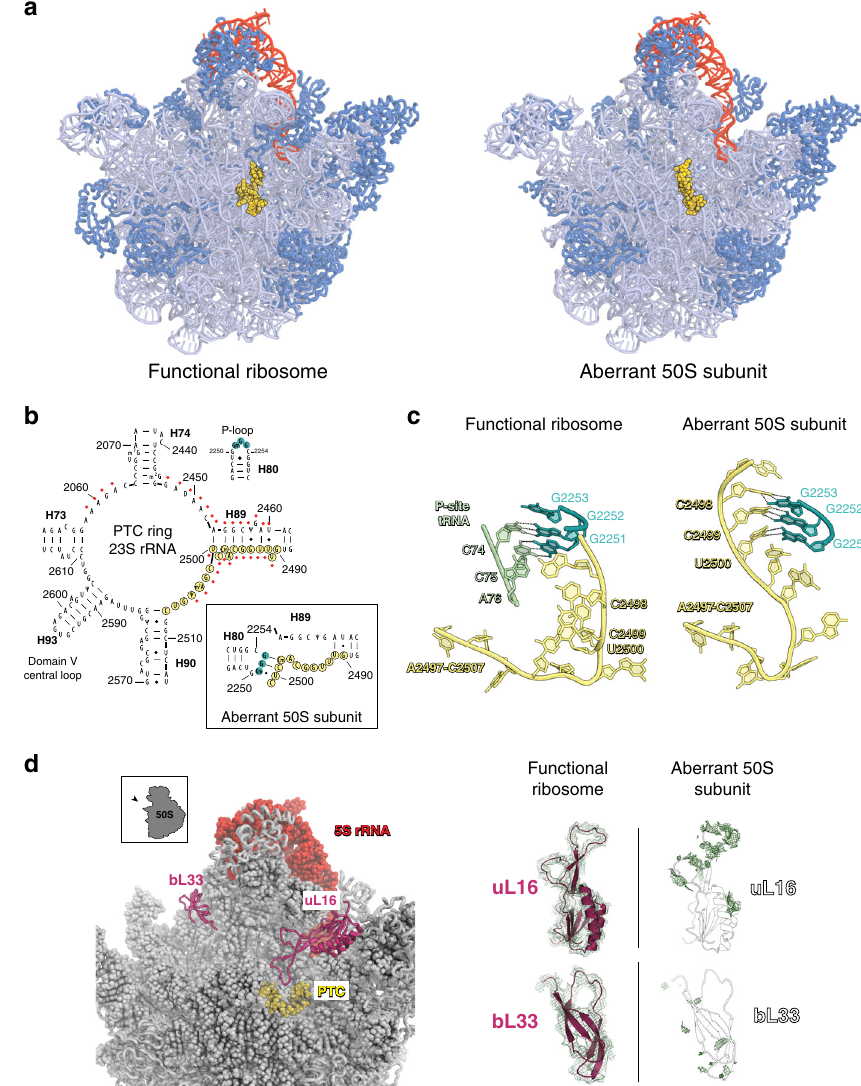
Fig. 7 The structure of the aberrant 50S subunits with 23S-cp5S rRNA. a Cryo-EM reconstruction of the structure of the 50S subunit in the functional 70S ribosomes (left panel) and unassociated 50S subunit (right panel) containing the 23S-cp5S rRNA. 23S rRNA is light blue, 5S rRNA is red, r-proteins are dark blue. The segments of the PTC rRNA that is remodeled in the aberrant 50S subunit is shown in yellow. b The secondary structure diagram of the central ring of domain V of the 23S rRNA that constitutes the heart of the PTC active site. The rRNA residues misplaced in the aberrant 50S subunits are indicated with red dots. The inlet shows the change in the structure at the H89 base: rearrangement of the PTC structure results in the unwinding of the fi rst helical turn of H89 (see also Supplementary Fig. 5b). c Interaction of the 23S rRNA P-loop (dark blue) with the CCA end of the P-site bound tRNA (green) in the functional ribosome or 23S rRNA segment 2497 – 2507 (yellow) in the aberrant 23S-cp5S large ribosomal subunits. rRNA strands are colored as in b . In the aberrant 50S subunit, the interaction of the tRNA with P-loop is blocked by the abnormal intramolecular pairing within the 23S rRNA. d Proteins uL16 and bL33 are lacking in the aberrant 50S subunits. Left: the location of uL16 and bL33 (purple) in the large subunit of the active 70S ribosome. 5S rRNA is red. The 23S rRNA segment 2490 – 2507 in the PTC active site (see b ) is shown in yellow. Right: the cryo-EM density for uL16 and bL33 (green mesh) is largely missing in the aberrant 50S